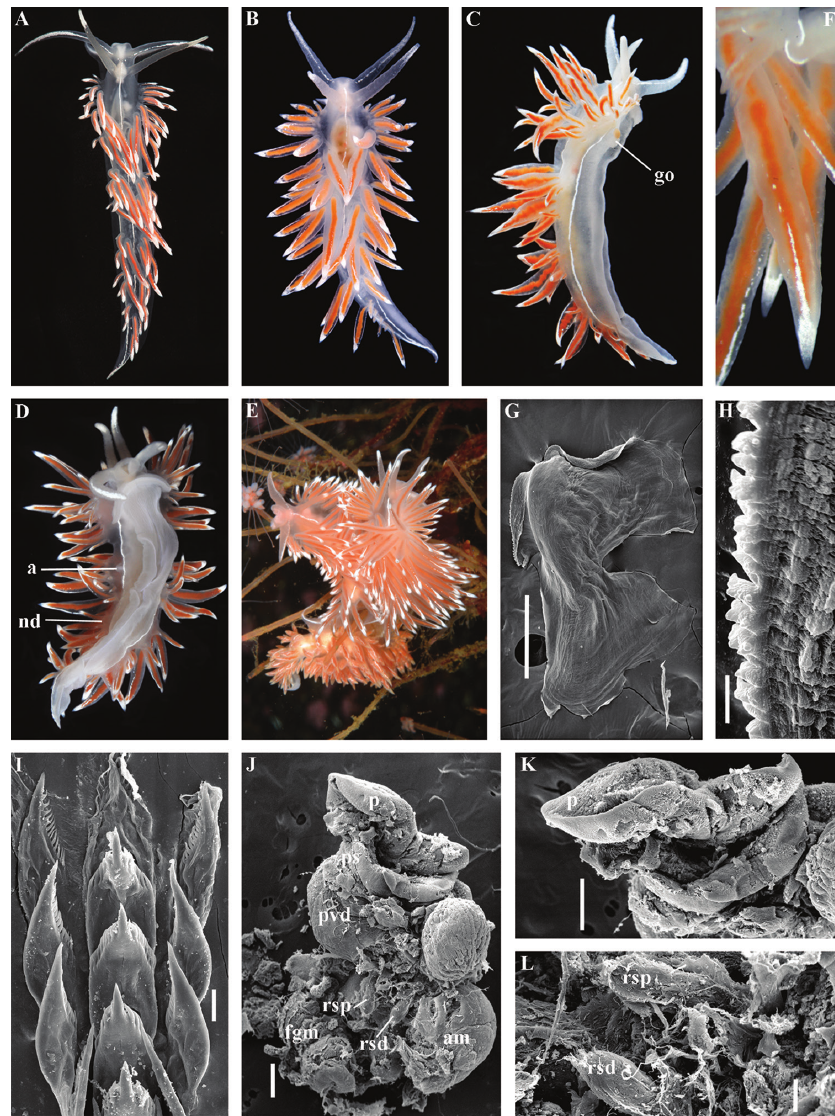
Figure 24. Fjordia lineata (Lovén, 1846), comb. n. A neotype 11 mm length (fixed), dorsal view (live), NTNU-VM-72483, Idefjorden, Sverige B living specimen 21 mm length dorsal view (ZMMU Op- 507) F same, details of cerata C ZMMU Op-508, lateral view D same, ventral view E living specimens (not collected) on a hydroid colony G jaw, SEM (ZMMU Op-507) H details of masticatory process of jaw, SEM (ZMMU Op-507) I radular teeth, posterior part, SEM (ZMMU Op-508) J reproductive sys- tem, SEM, scale bar = 1 mm (ZMMU Op-507) K penis, SEM (ZMMU Op-507) L seminal reservoirs (ZMMU Op-507). Abbreviations: a anus am ampulla rsd distal receptaculum seminis fgm female gland mass go genital opening p penis ps penial sheath pvd prostatic vas deferens rsp proximal receptaculum seminis. Scale bars: G, I, K = 300 μm H = 10 μm; J = 1 mm; L = 100 μm. Photos of living specimens by T.A. Korshunova ( A, C, D ), and B. Picton ( B, E ), SEM images by A.V.